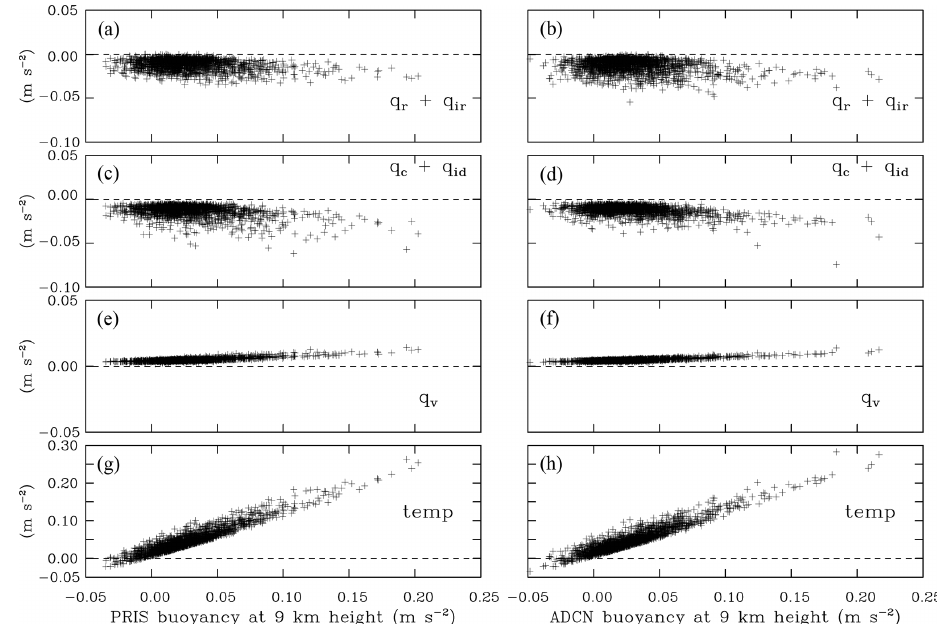
Figure 11. Like Fig. 10, but at 9km. Panels (a, b) include rain mixing ratio combined with ice mixing ratio grown by diffusion of water vapor; panels (c, d) include cloud water combined with ice mixing ratio grown by